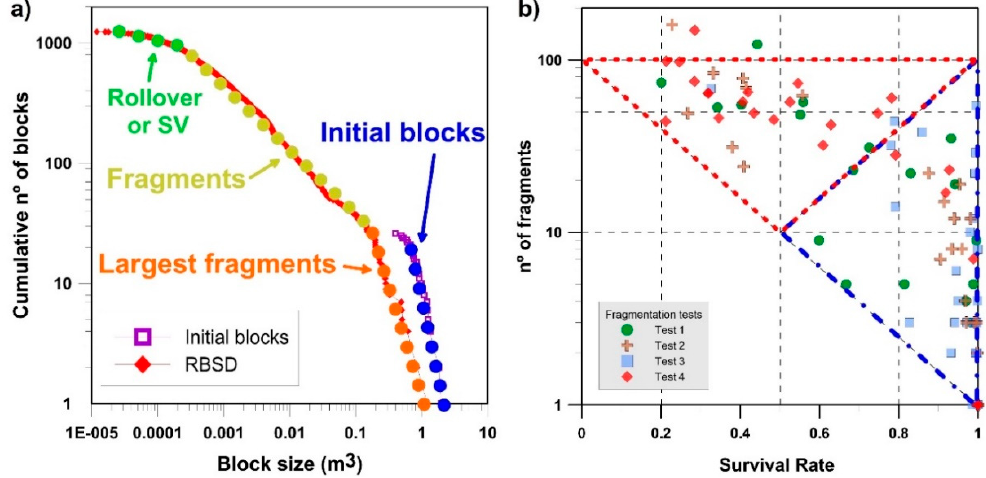
Figure 21. Conclusions schemes: ( a ) initial blocks and rockfall block size distribution (RBSD) generated based on Test 4 data; ( b ) fragmentation characterization combining the Sr and the number of fragments.